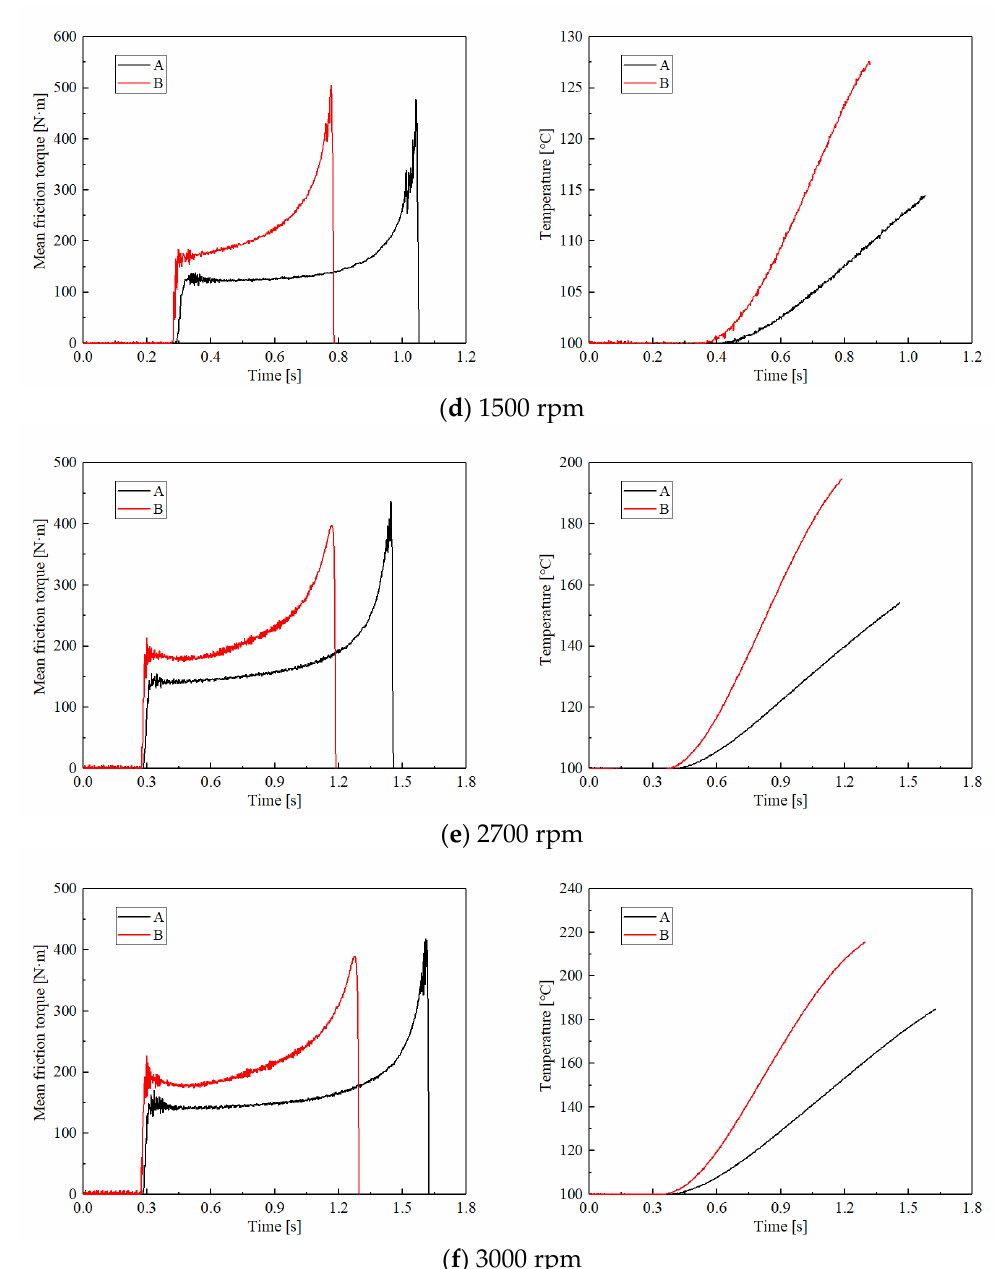
Figure 8. Variations of the friction torque with rotating speeds of CBFM-A and CBFM-B ( a – f ).